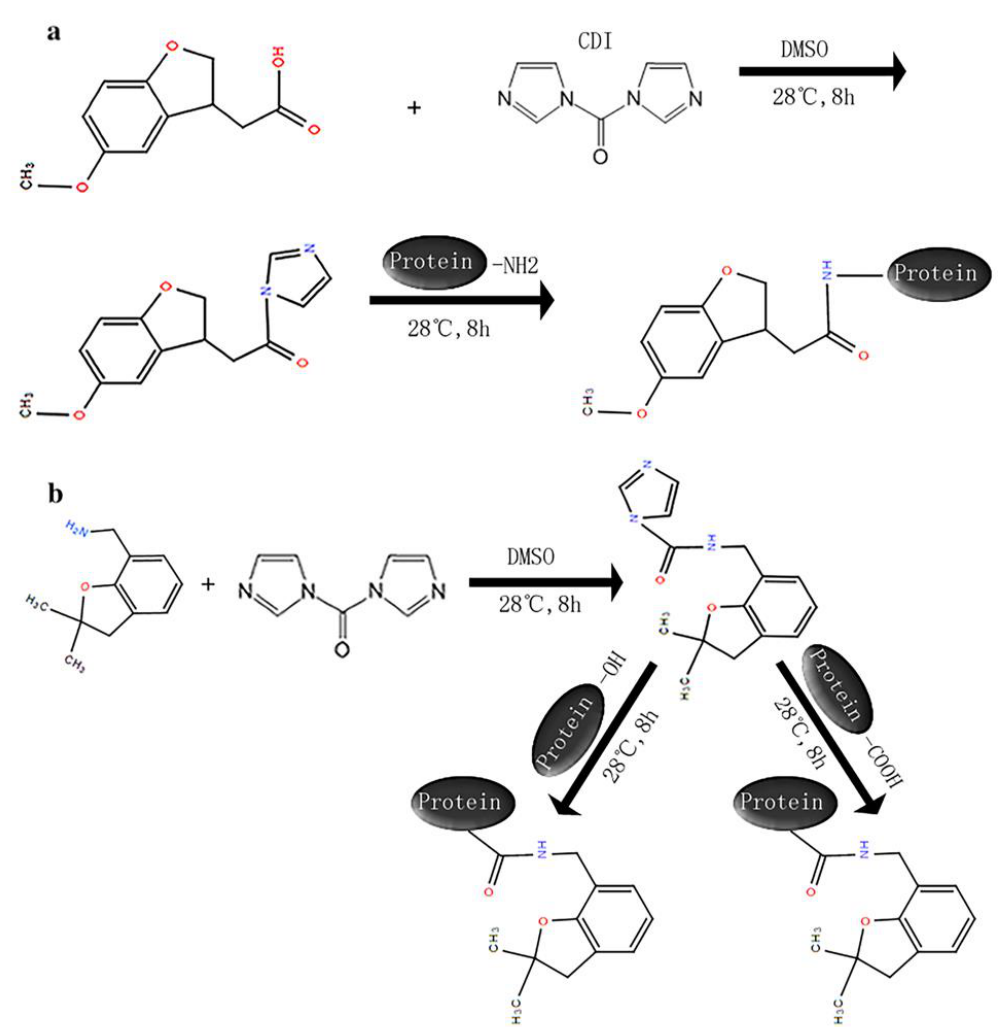
Figure 2. The synthetic routes for the immunogen and coating antigen. ( a ) Conjugation progress of hapten MDA to carrier protein ( b ) Conjugation progress of hapten DDB to carrier